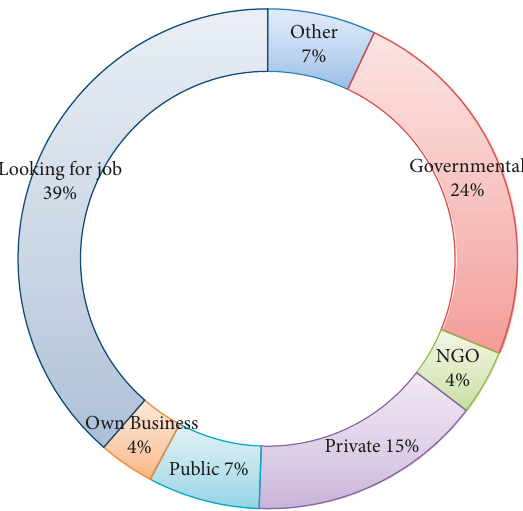
Figure 3: Sectorial distribution of employed graduates.